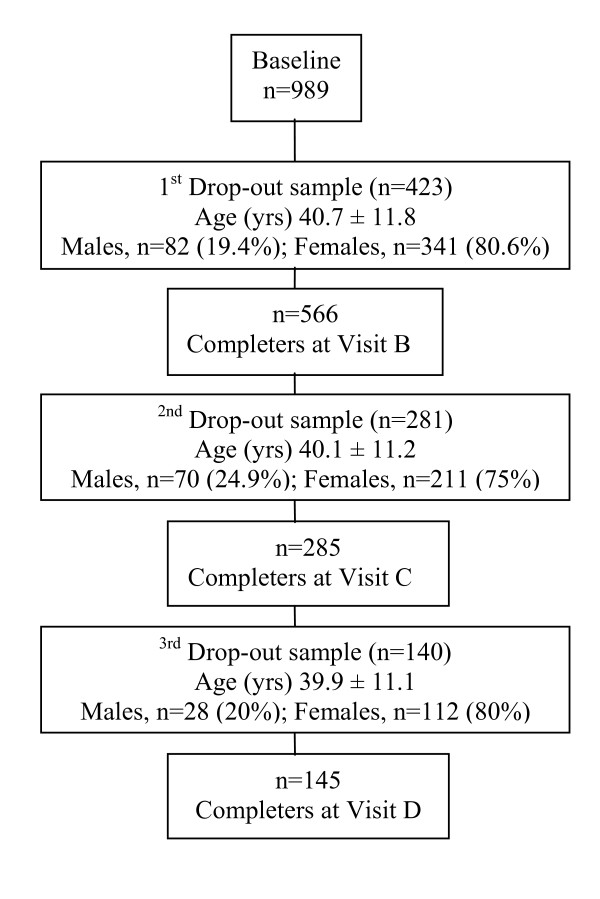
Participants' Flow.